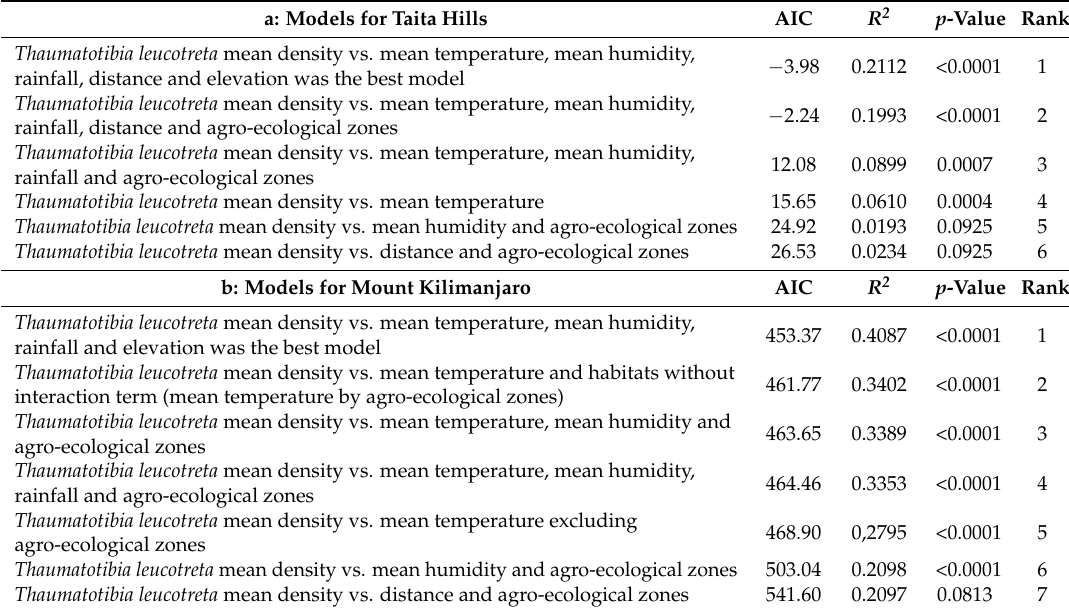
Table 3. Linear mixed effect models explaining change in abundance of Thaumatotibia leucotreta along agro-ecological zones at Taita Hills, Kenya and Mount Kilimanjaro, Tanzania. a: Models for Taita Hills AIC R 2 p -Value Rank